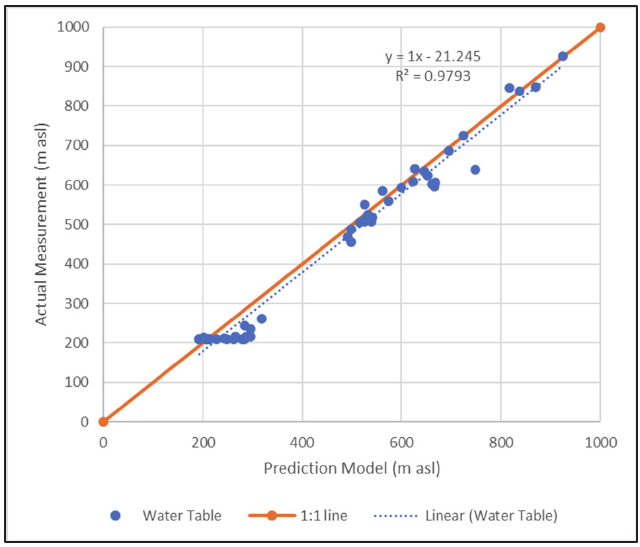
Figure 20. Scatter plot of actual water table measurement and predicted water